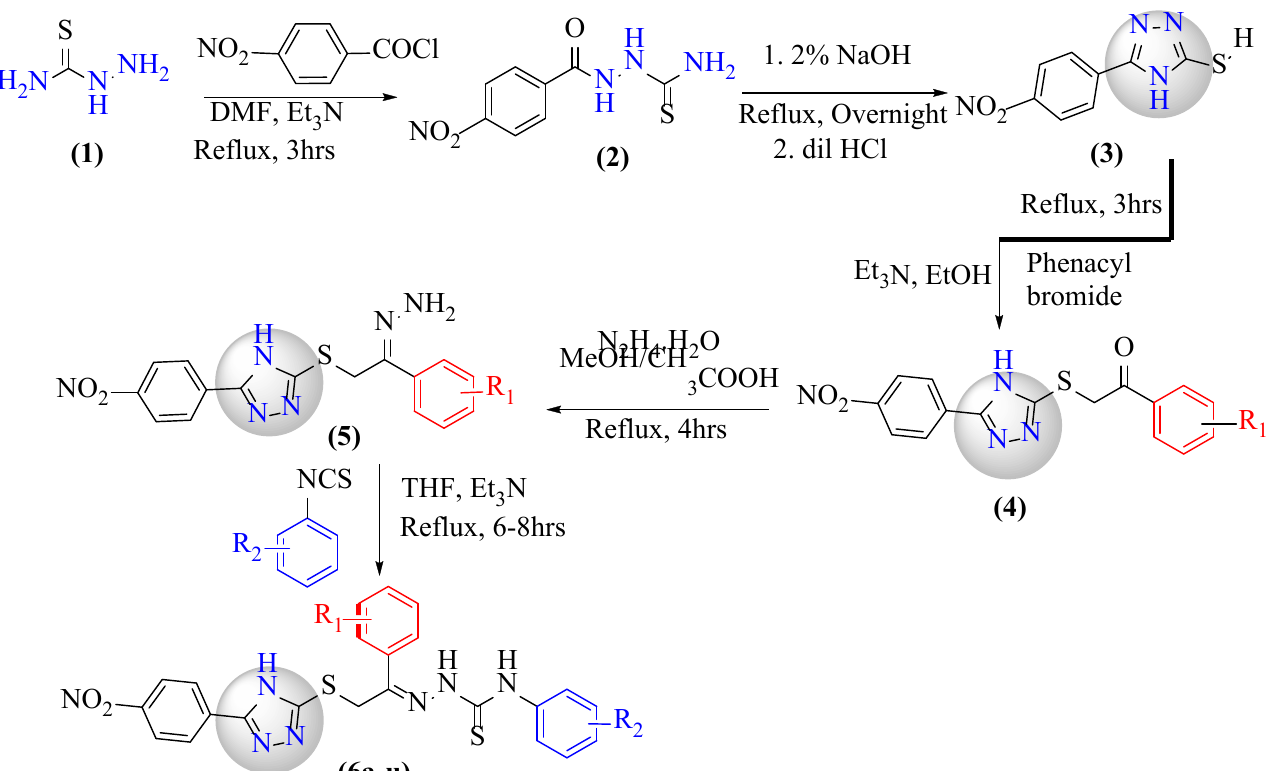
Scheme 1. Synthesis of triazole-based thiosemicarbazone derivatives ( 6a–u ).